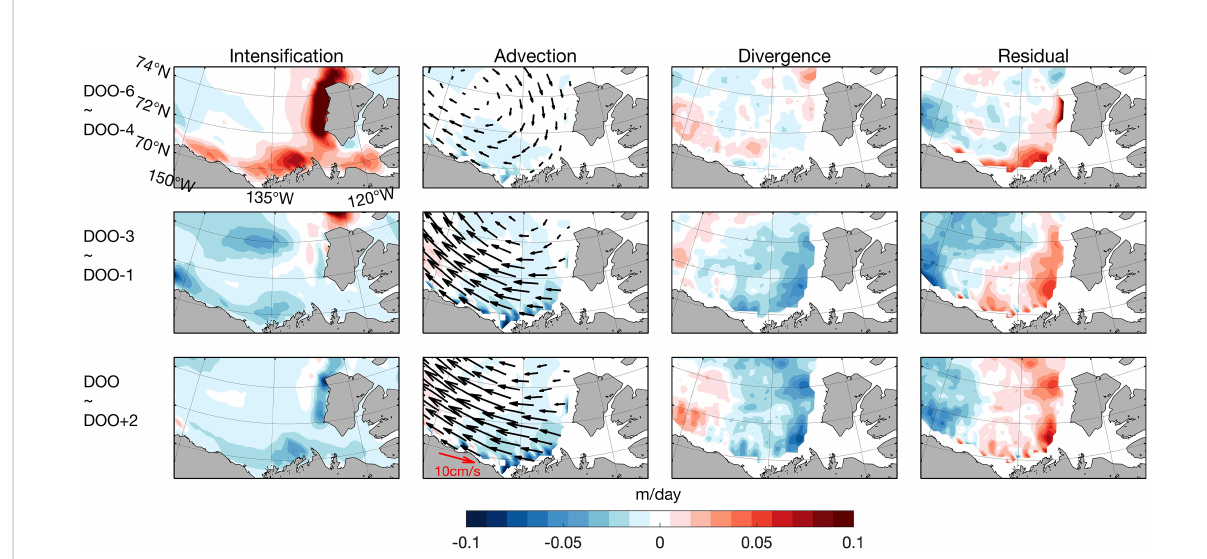
FIGURE 6 Sea ice volume budget components, including (left to right) intensi fi cation, advection, divergence, and residual terms (top) prior to (DOO-6 to DOO-4), at the start of (DOO-3 to DOO-1), and during the peak of southeasterly winds (DOO to DOO+2). Units are m day − 1 . Blue (red) values indicate a decrease (increase) in sea ice